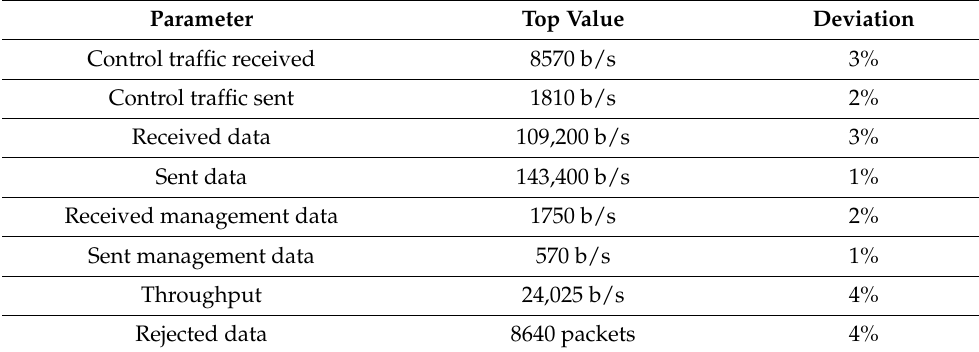
Table 3. The overall statistics of the network operation in the first scenario.